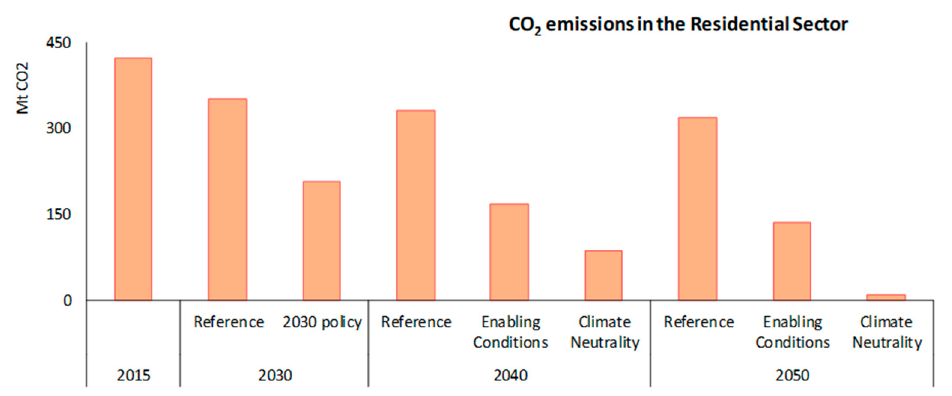
Figure 3. Final energy for the heating and cooling of houses.